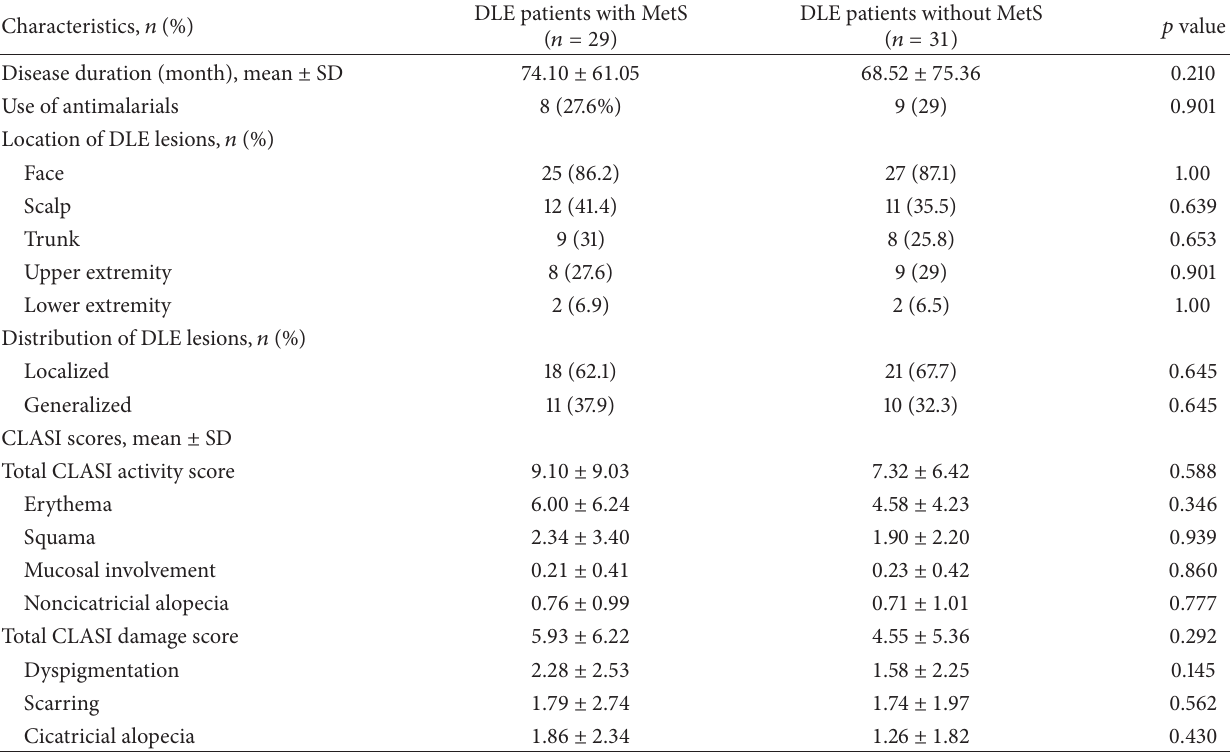
Table 3: Comparison of clinical characteristics in DLE patients with and without metabolic syndrome. Characteristics, 𝑛